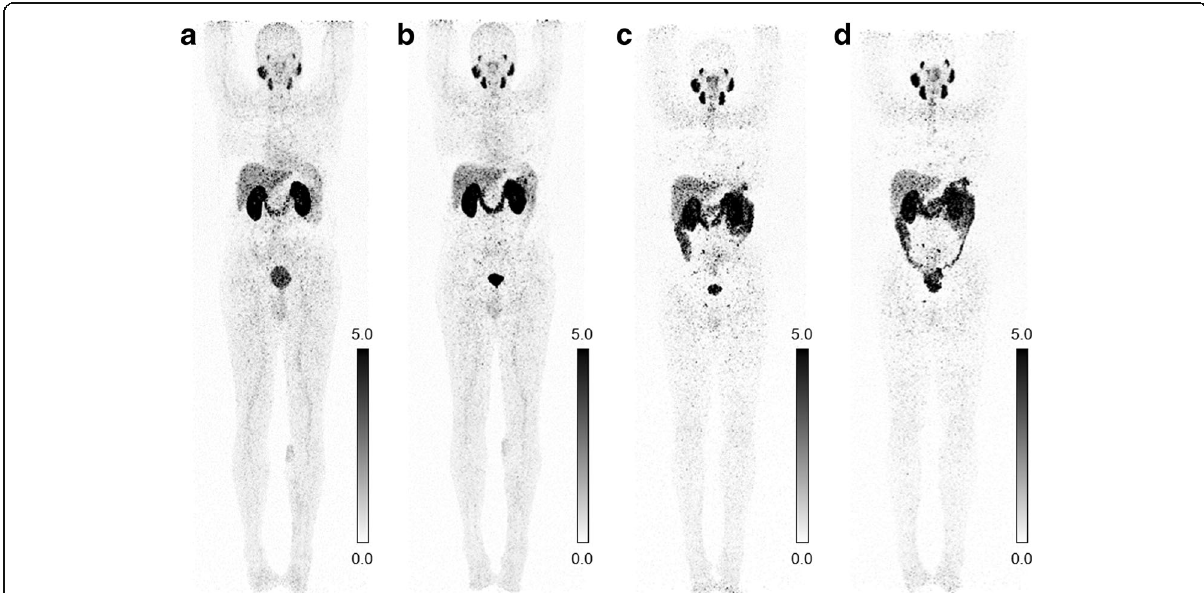
Fig. 3 Physiological biodistribution of 152 Tb-PSMA-617 on PET/CT scans (MIP images) obtained at a 50 min, b 2 h, c 18.5 h, and d 25 h, respectively, after injection of 140 MBq 152 Tb-PSMA-617. Physiological accumulation of the radioligand is observed in the blood pool (decreasing over time), lacrimal, parotid, and submandibular glands (strong), the nasopharyngeal mucosa as well as in the liver, spleen (faint), and the intestinal tract (increasing over time). Uptake in the kidneys and retention of activity in the urinary bladder are due to renal excretion